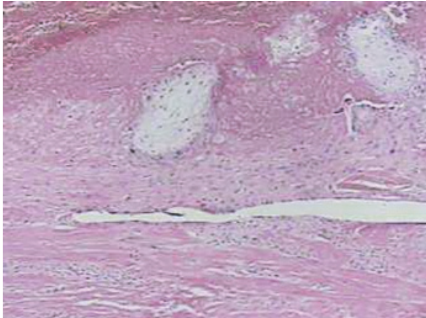
Figure 1: Ultrasound showing topic pregnancy at 13 weeks of gestation.